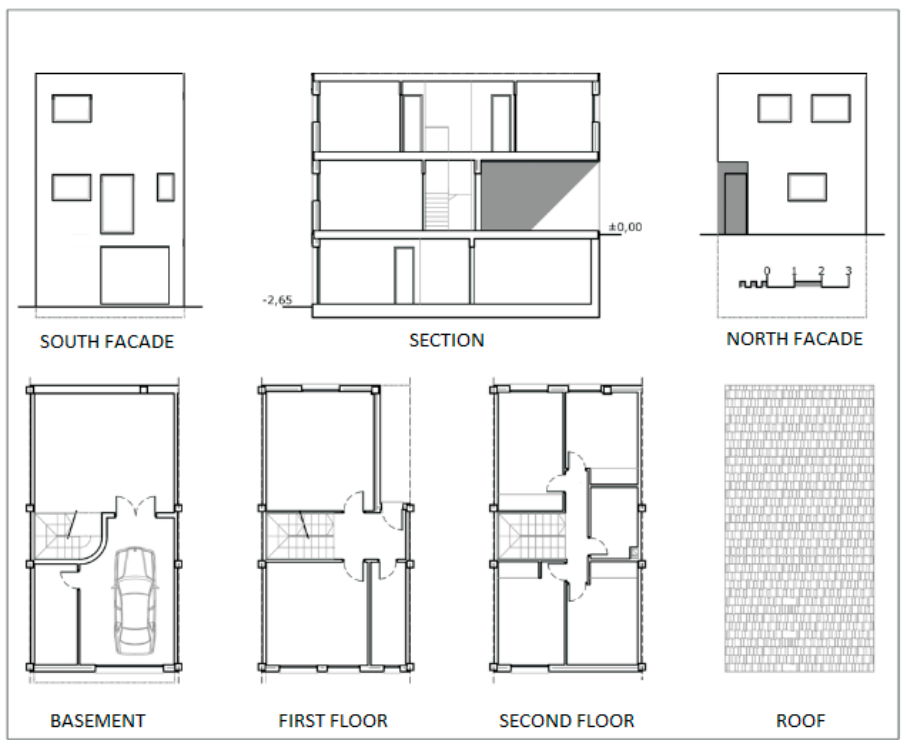
Figure 3. Plan of the single-family house.